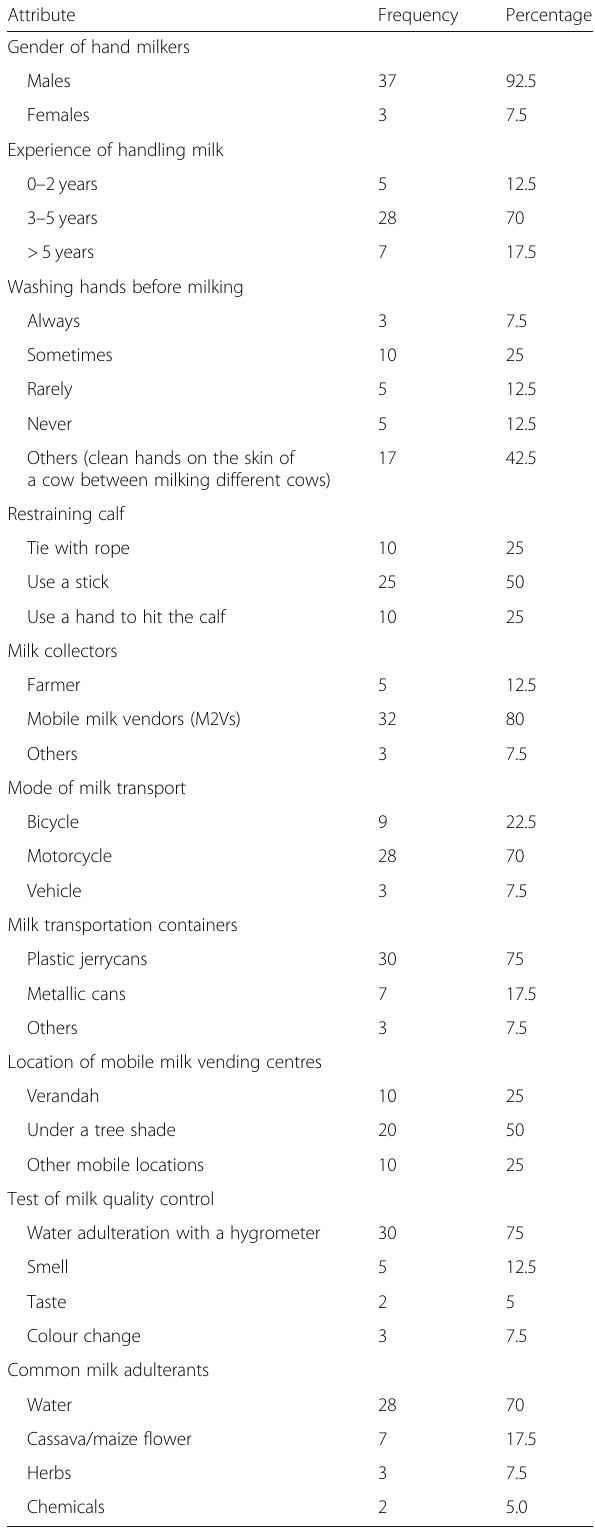
Table 2 Milk handling and transportation in